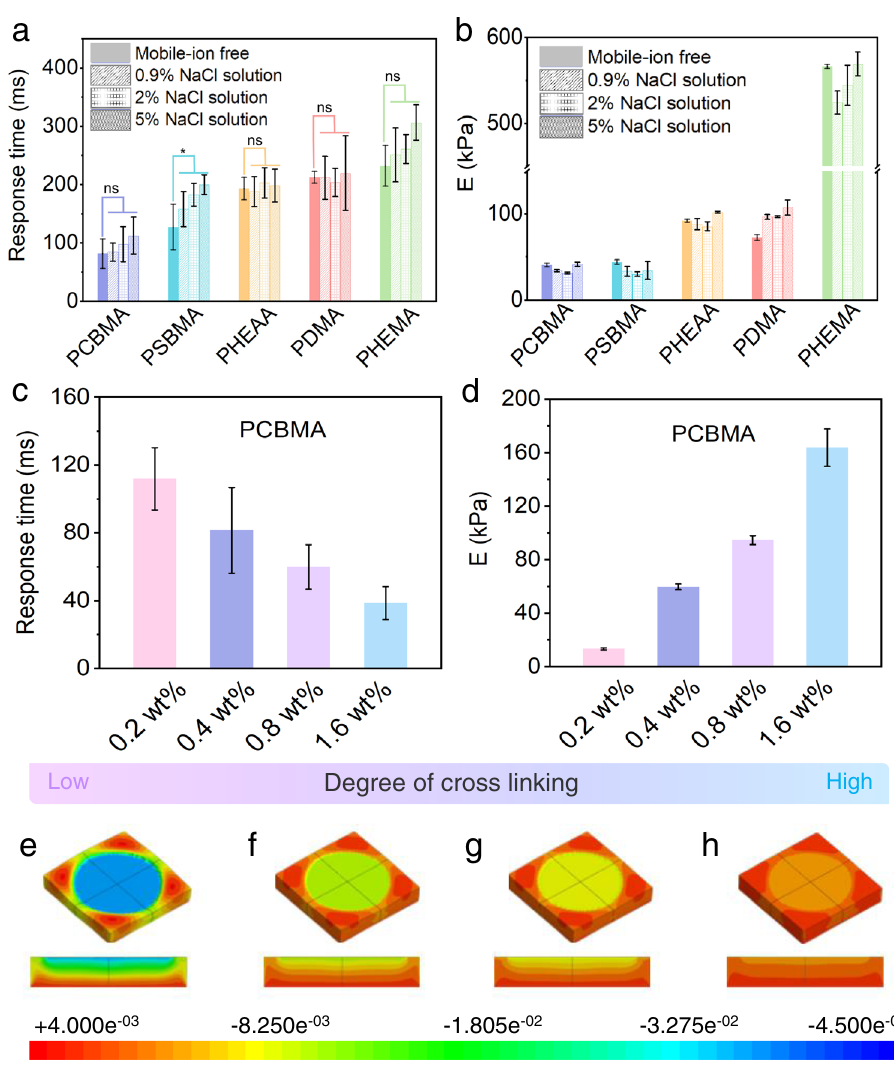
Fig. 4 | Response time of the hydrogels. a Response times of zwitterionic and nonionic hydrogels under a small pressure (0.77kPa) in the mobile-ion-free and mobile-ion-added (NaCl) systems. Data are reported as their means±SDs ( N ≥ 3). ns: no signi fi cance. b Compression elastic moduli of the hydrogels. Data are reportedastheir means±SDs ( N ≥ 3). c Response timesand d , compressionelastic moduli of the PCBMA hydrogels with different crosslinking degrees (cross-linker contents of 0.2wt%, 0.4wt%, 0.8wt%, and 1.6wt%, left to right) under a small